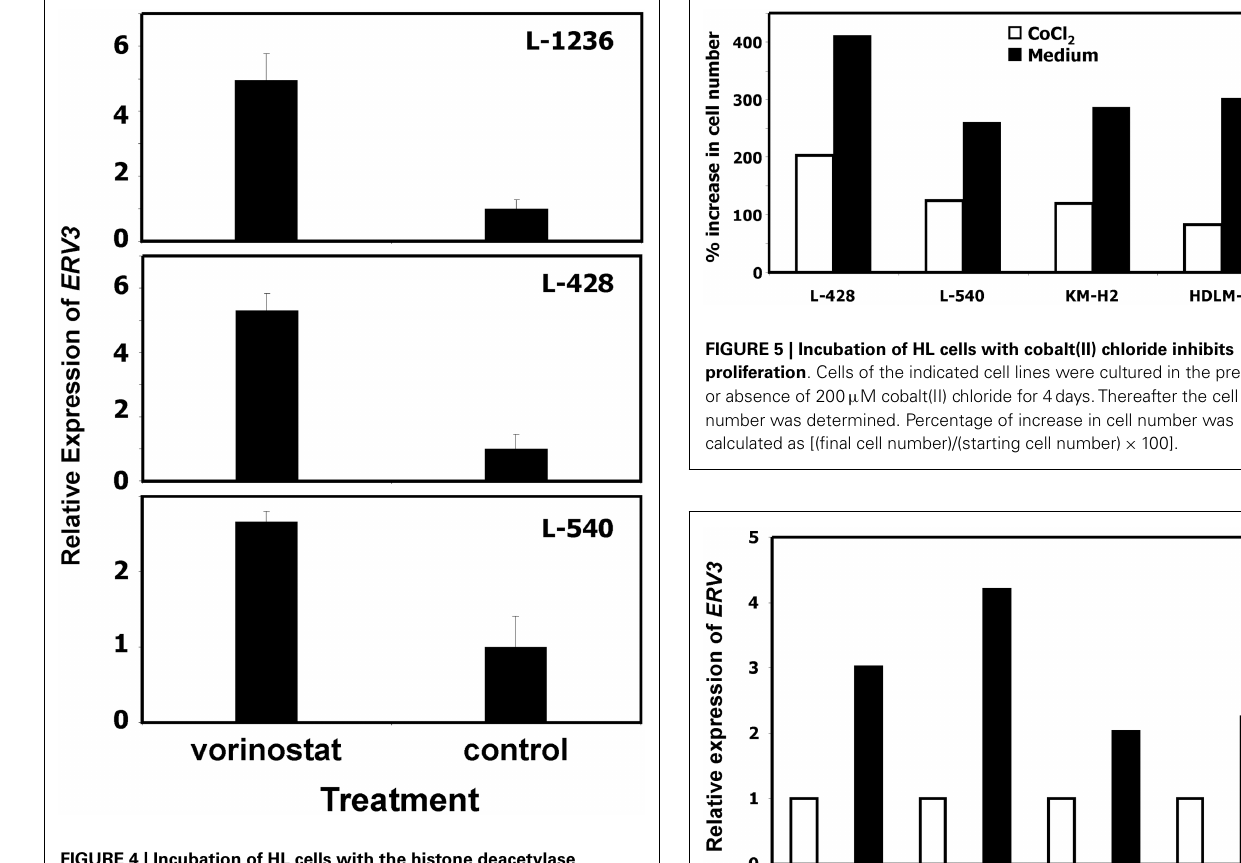
FIGURE 4 | Incubation of HL cells with the histone deacetylase inhibitor vorinostat leads to increased expression of ERV3 . Expression of ERV3 was analyzed in HL cell lines with and without 1 µ M vorinostat by quantitative RT-PCR. Presented are means and standard errors from triplicates. Beta actin was used as housekeeping control and the mean of the HL cells without vorinostat was set as 1. CoCl 2 led to a pronounced inhibition of proliferation ( Figure 5 ).